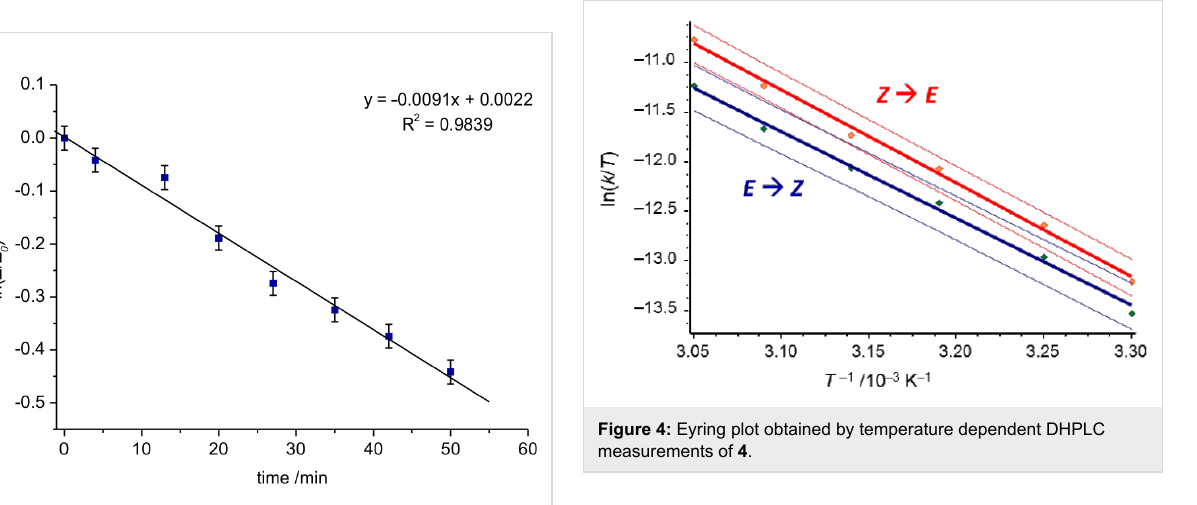
Figure 2: Equilibration of the E -rotamer of 4 at 293 K.